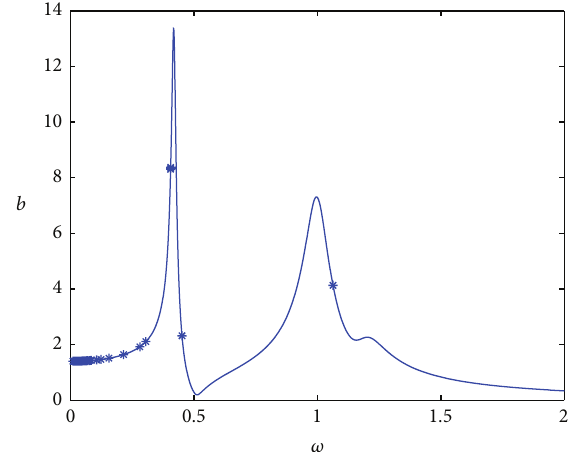
Figure 7: Schematic of codimension-two grazing bifurcation points for 𝑛 = 2 .